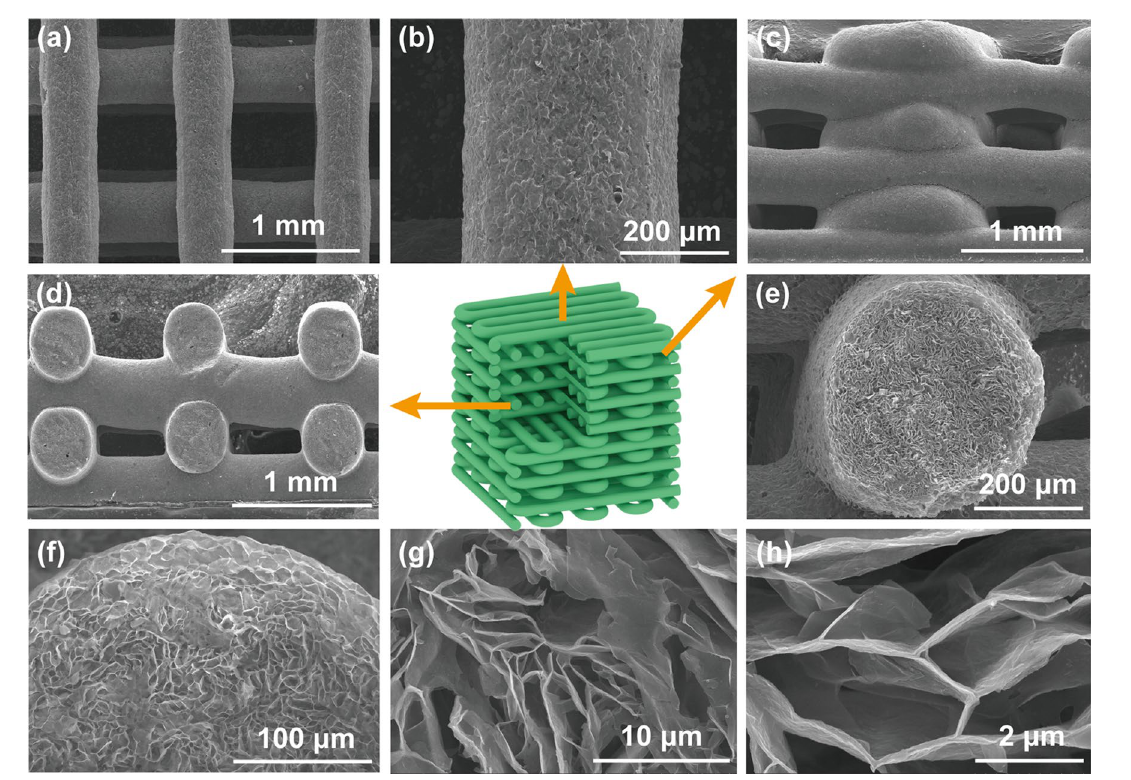
Fig. 2 SEM images of porous MG2 with a wood‑pile structure from different directions: a, b top view, c side view, and d, e cross‑sectional view. f–h Cross‑sectional SEM images of MG2 cross‑linked by aluminum